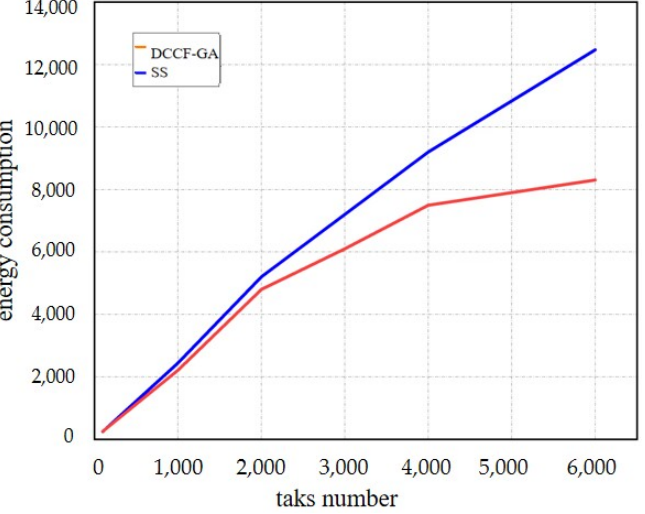
Figure 9. Performance comparison of DCCF-GA and SS in energy consumption.